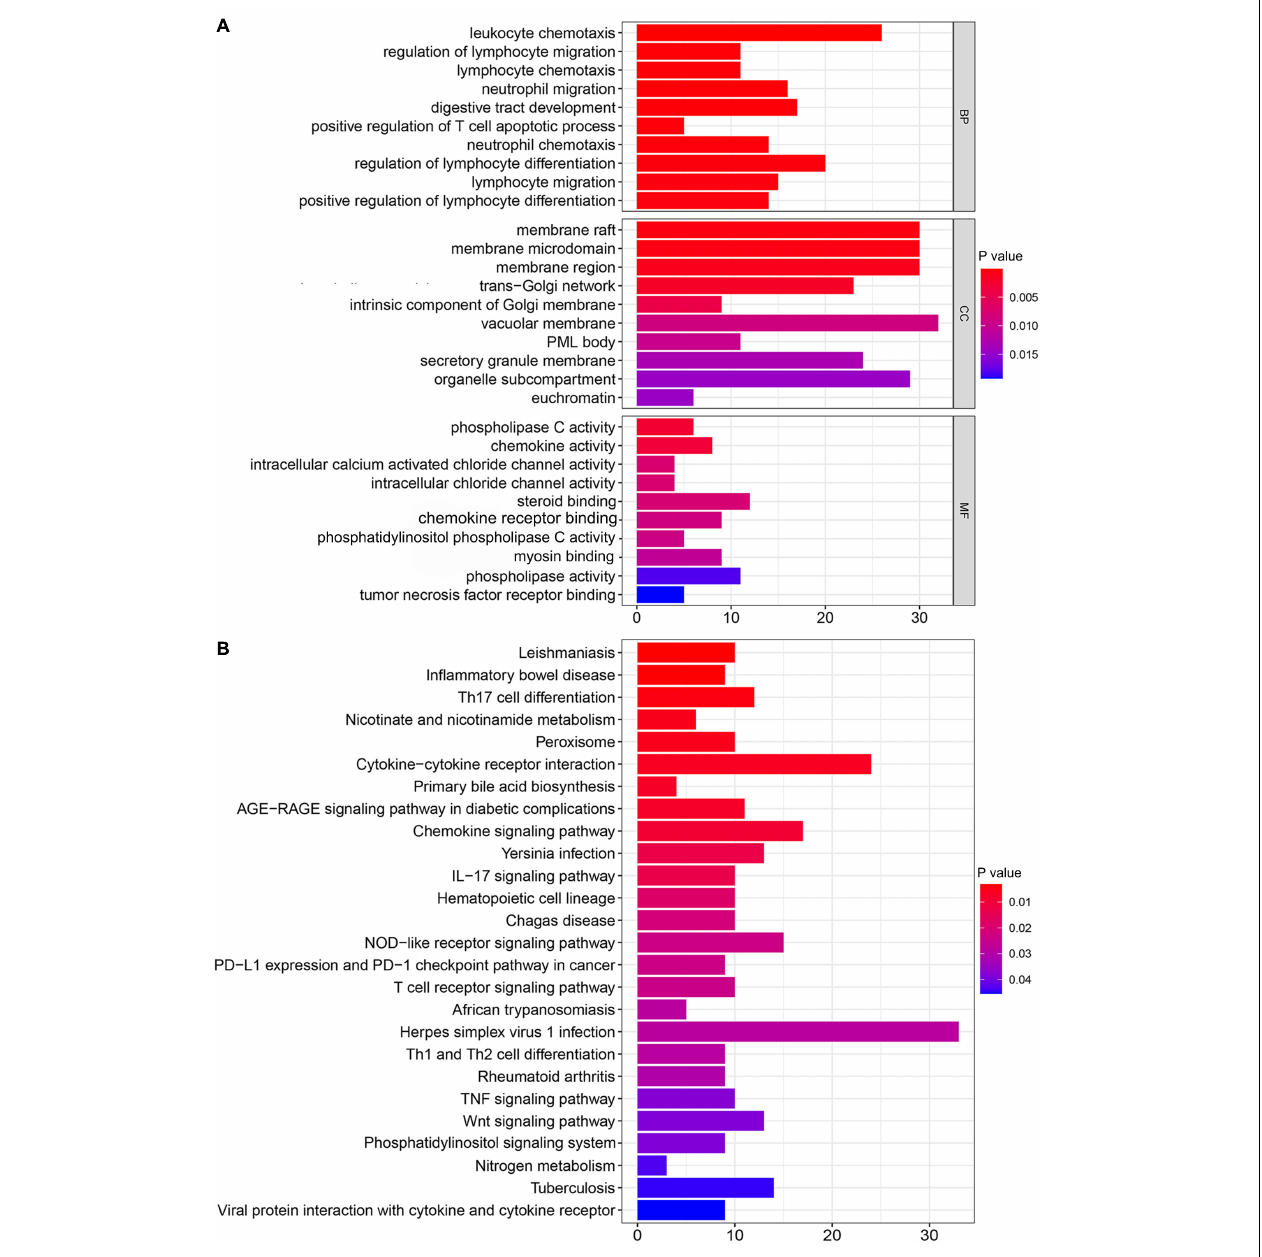
FIGURE 3 | Functional enrichment analysis of mRNAs co-expressed with genome instability-associated lncRNAs. (A) Gene Ontology (GO) analysis of biological processes (BPs), cellular components (CCs), and molecular functions (MFs). (B) Kyoto Encyclopedia of Genes and Genomes (KEGG) pathway analysis.